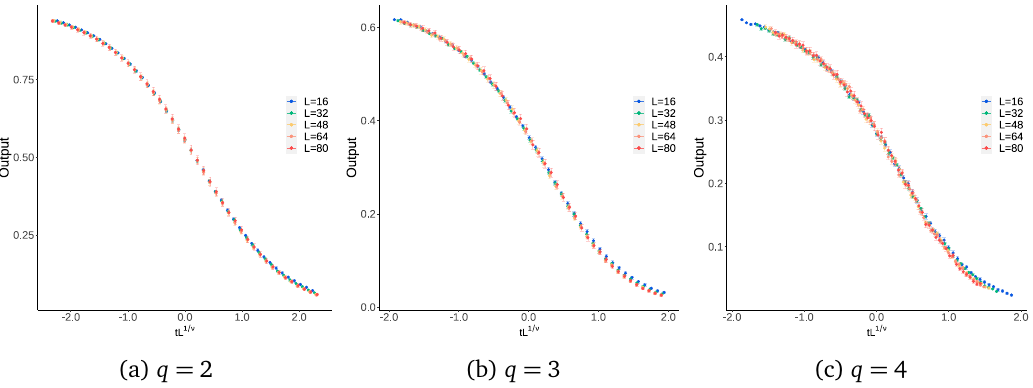
Figure 17: The finite-size scaled plots of the average output of an ensemble of 10 independently trained ANNs – training with MC data of the ferromagnetic square- lattice Ising model, and testing with MC data of the ferromagnetic q -state Potts model on a square lattice. The error bars shown are 99.7% confidence intervals of the ensemble